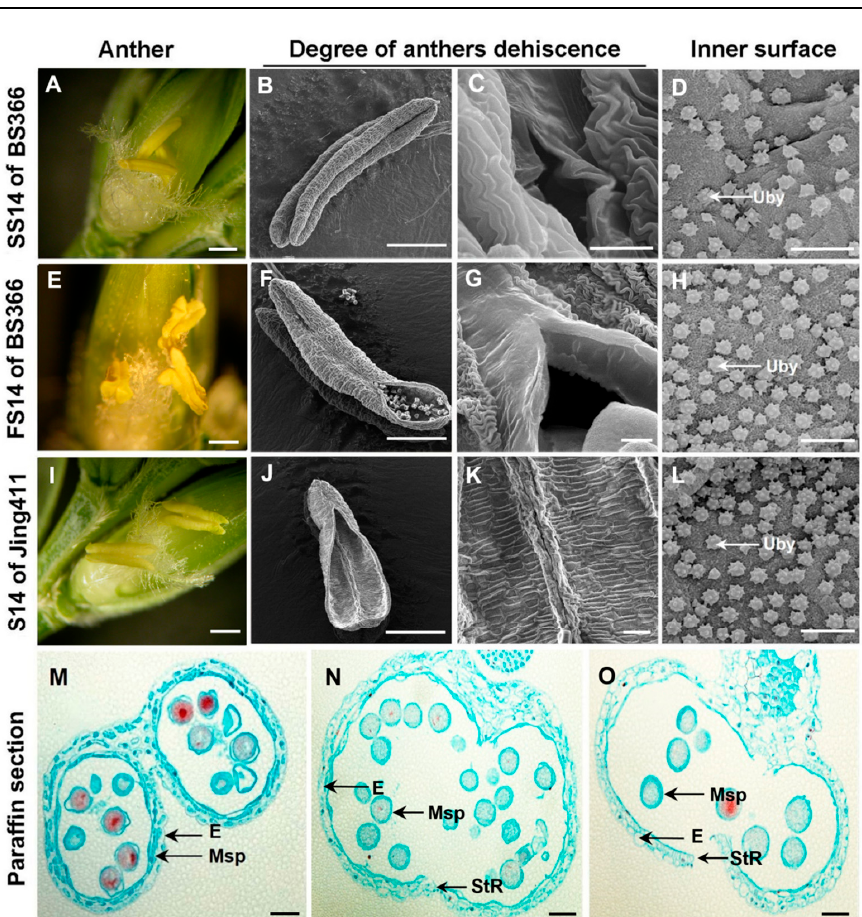
Figure 1. Morphological characterization of anther from BS366 of different fertility conditions